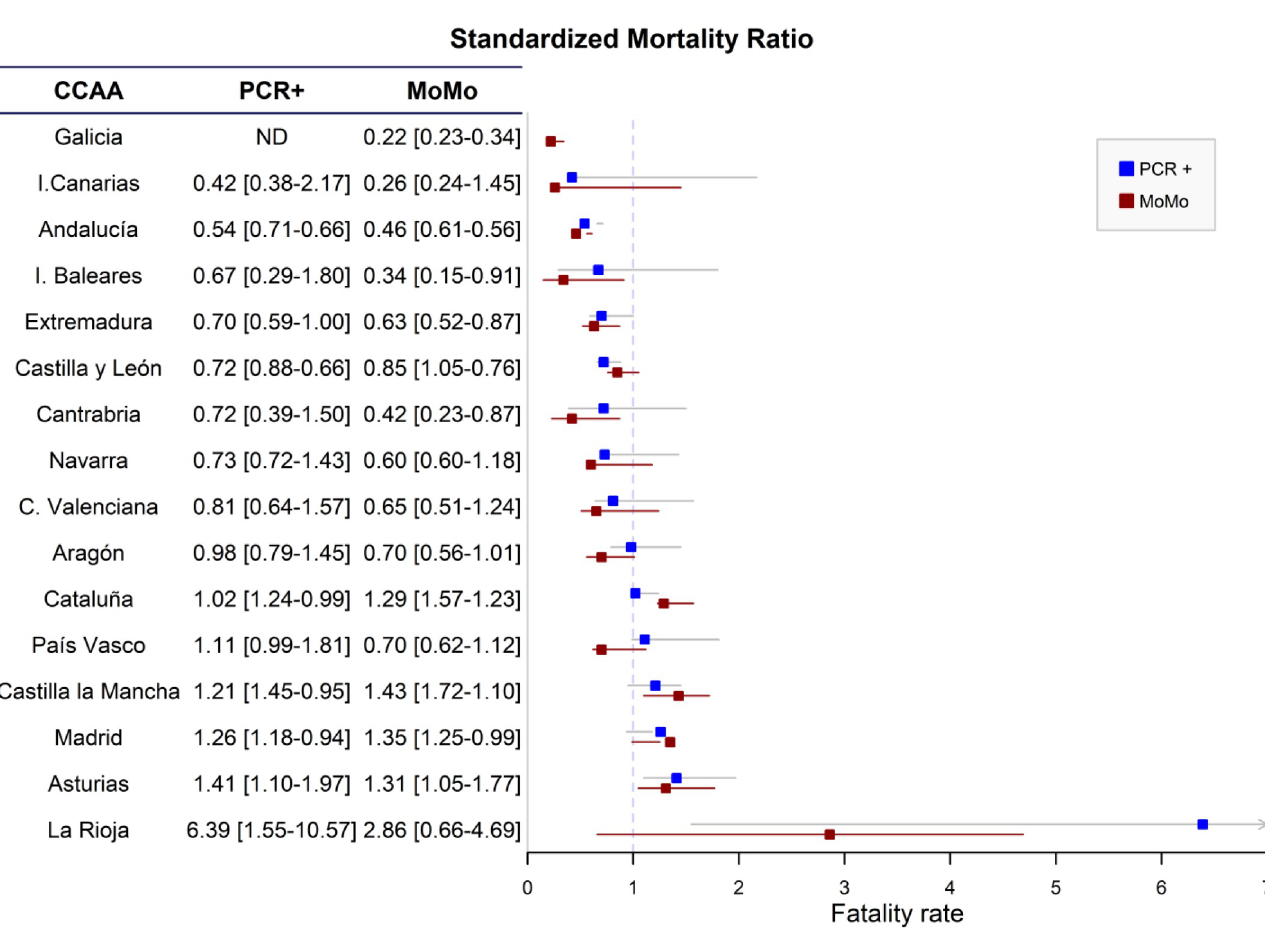
PLOS ONE | https://doi.org/10.1371/journal.pone.0260769 December3,